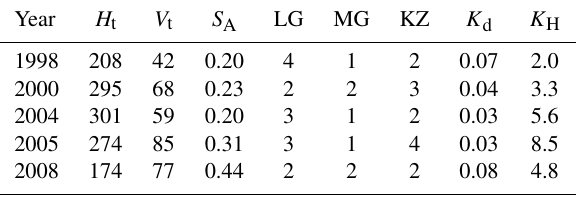
Table 1. Summary of channel data for individual surveys. H t , V t , and S A denotes total horizontal length along thalweg (in m), to- tal vertical height (in m), and average slope gradient (mm − 1 ) re- spectively. LG, MG, and KZ denotes number of reaches classified as low gradient, medium gradient, and knickzones respectively. K d denotes step density calculated as number of steps divided by total channel length along thalweg, and K H average step height (m).